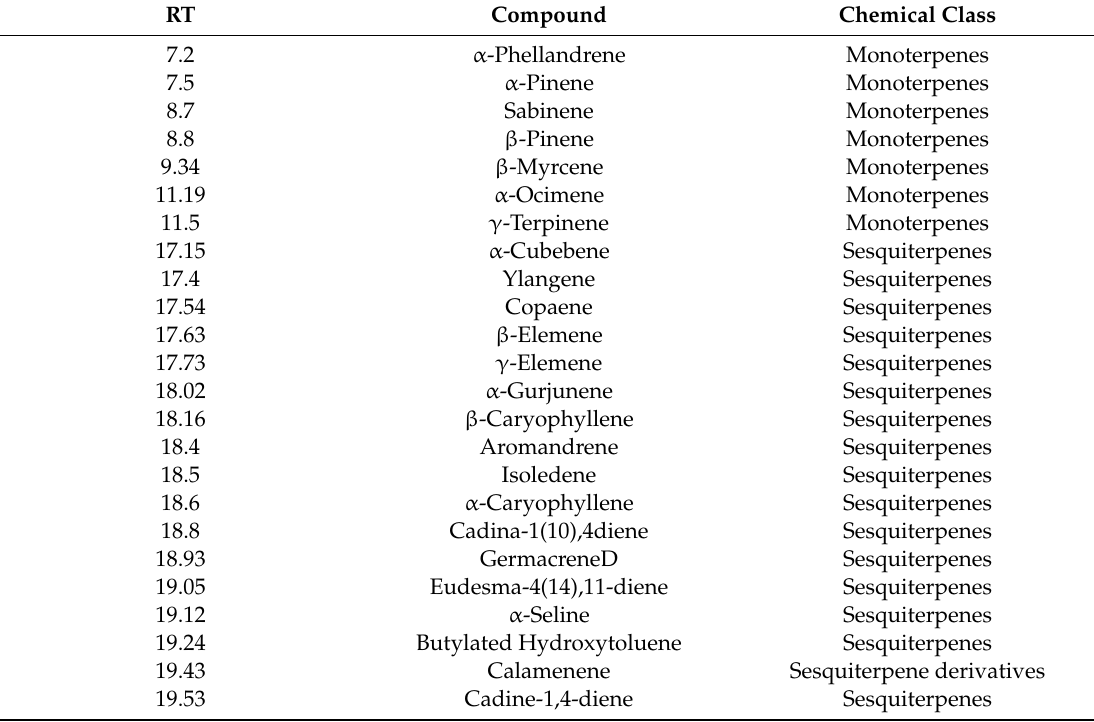
Table A1. List of compounds tentatively identified in the headspace samples of Clitarchus hookeri